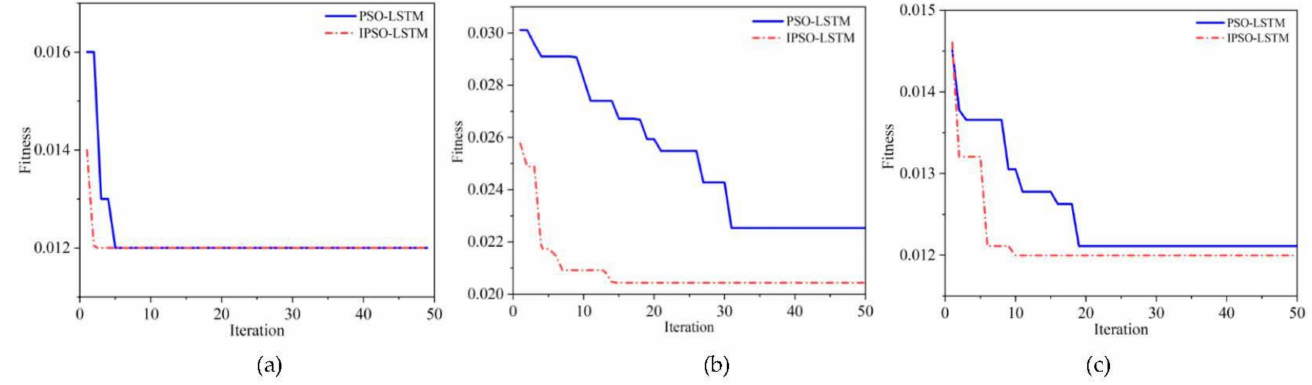
Figure 9. Optimization iteration results for the: ( a ) outer bearing; ( b ) roller bearing; ( c ) inner